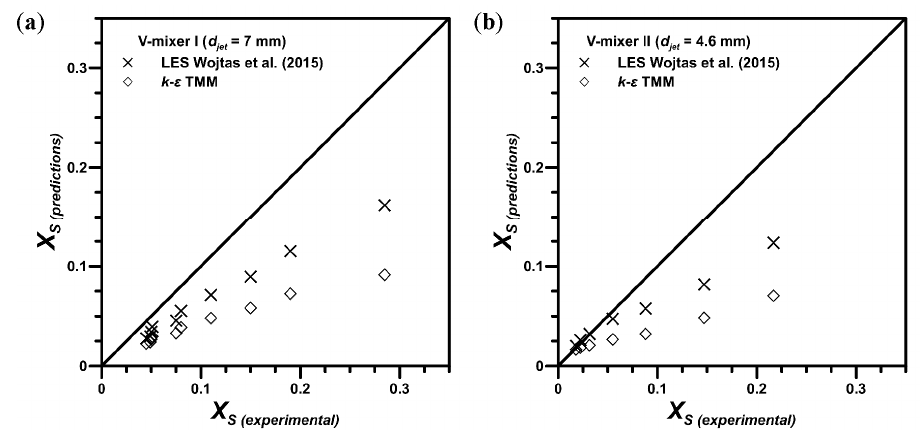
Figure 5. Parity plot showing predictions of the large eddy simulation (LES) and Reynolds-averaged Navier–Stokes (RANS) models: ( a ) V-mixer I; ( b ) V-mixer II.